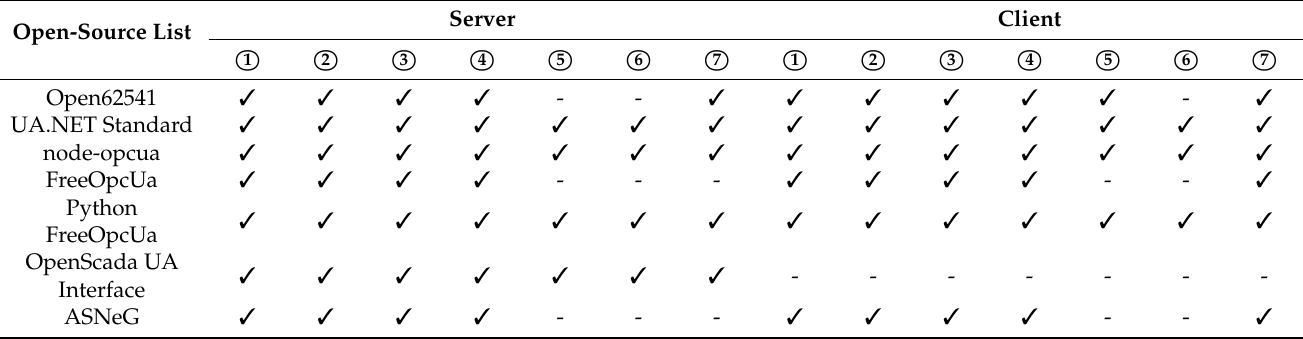
Table 12. Checklist for open-source implementations that meet the